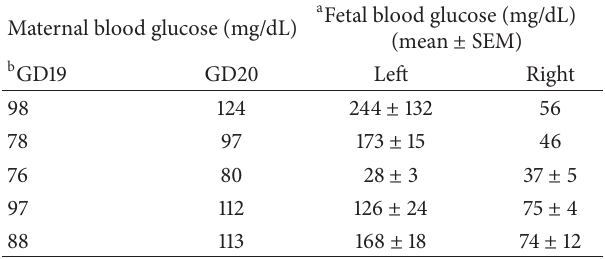
Table 2: Per dam maternal and fetal blood